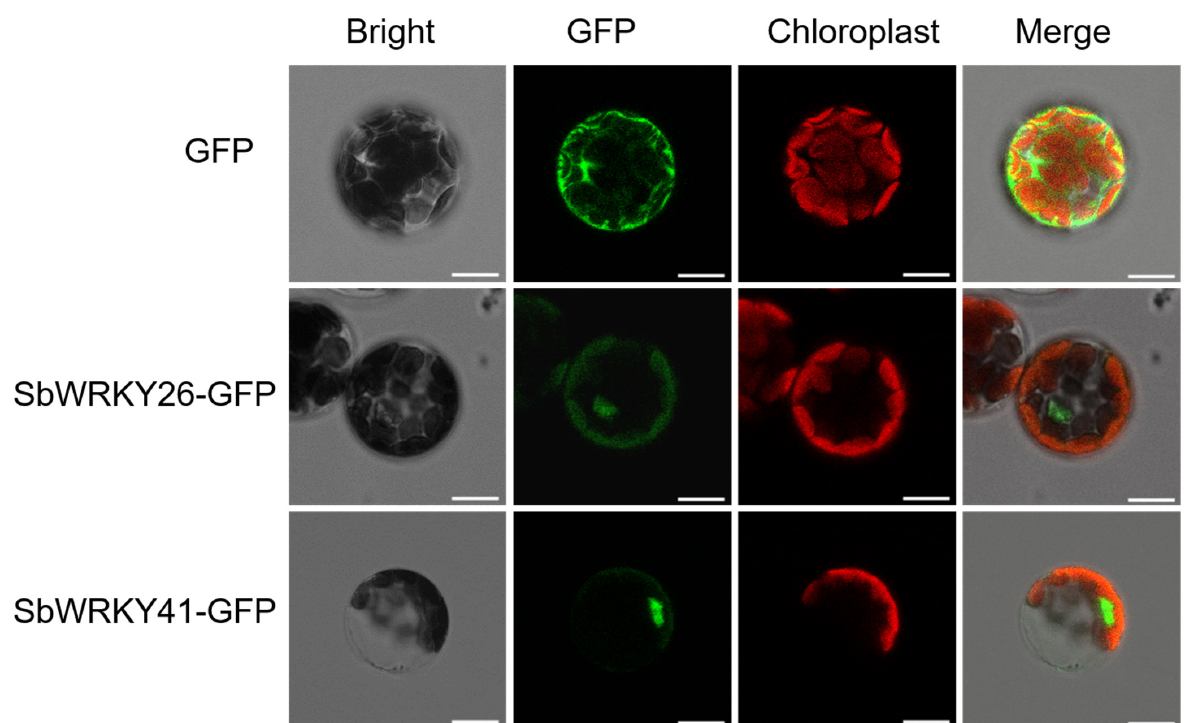
Figure 10. Subcellular localization analysis of SbWRKY26 and SbWRKY41. Subcellular localization of SbWRKY26-GFP and SbWRKY41-GFP in nucleus was confirmed in Arabidopsis protoplasts by laser confocal microscopy, with GFP as the positive control (Scale bar: 15 μ m).